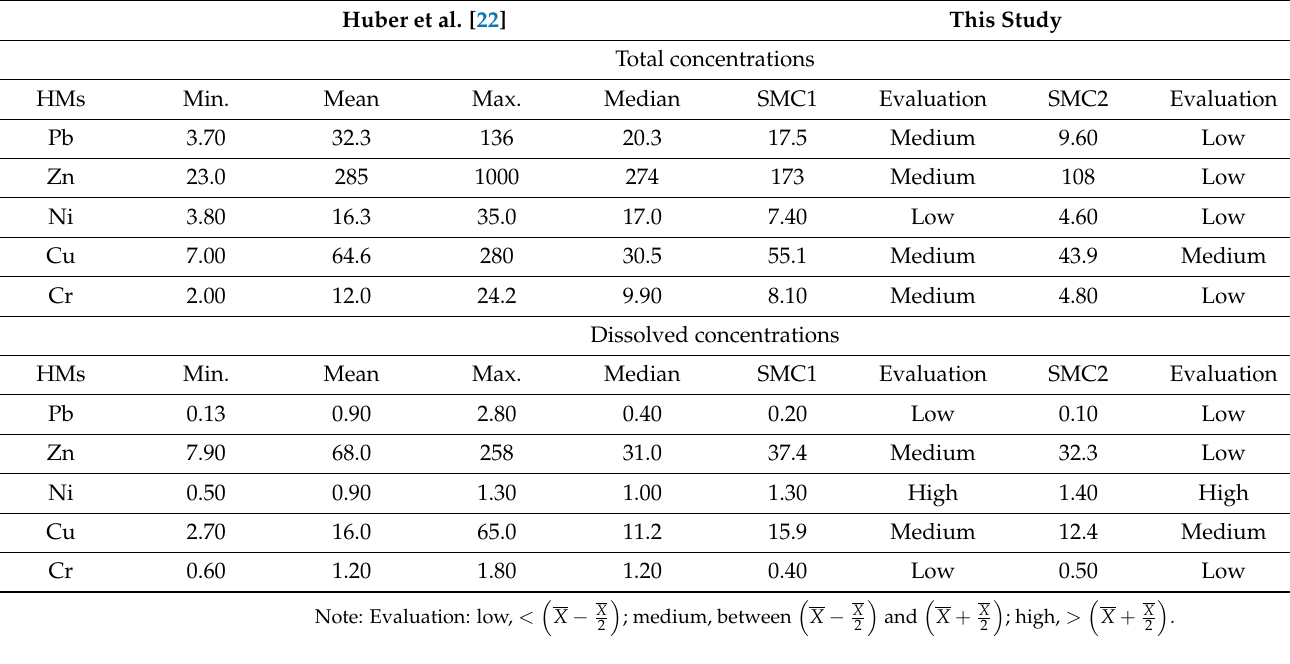
Table 4. Comparison of observed HM concentrations with those reported by Huber et al. [22]. Huber et al. [22] This Study Total